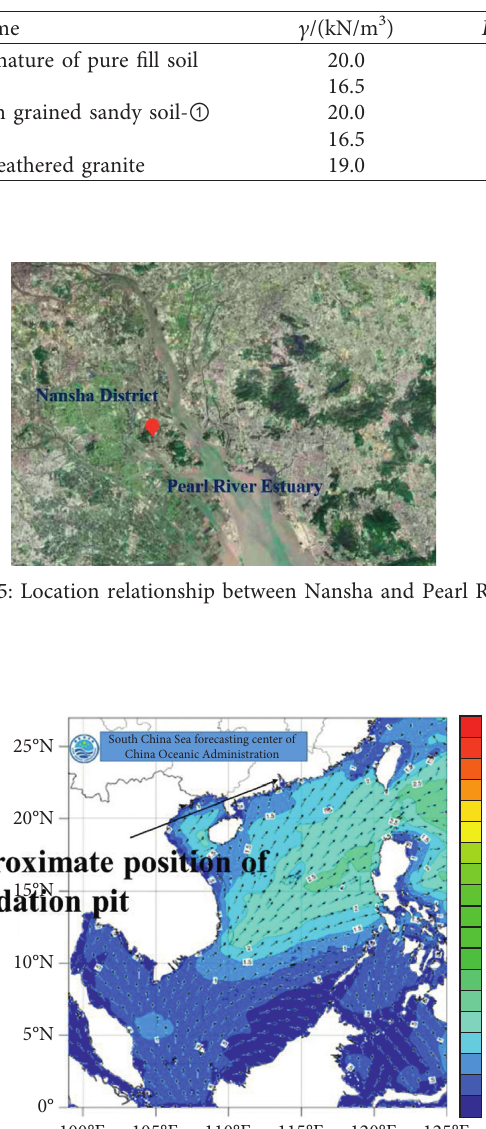
Table 1: Geotechnical engineering parameters of soil layer within the excavation range of the foundation pit.